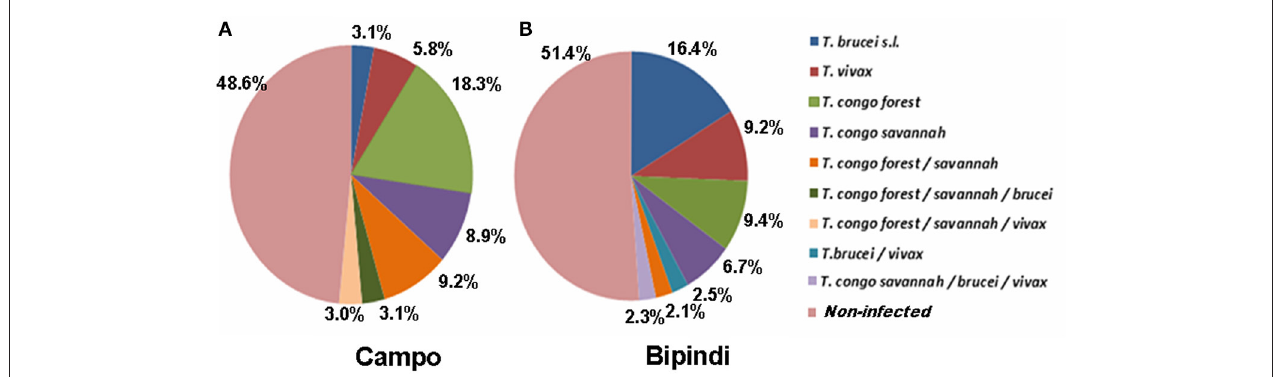
FIGURE 3 | Prevalence of the different trypanosome species or subspecies infecting tsetse flies collected in the Campo (A) and Bipindi (B) foci. Single as well as mixed infections have been considered.